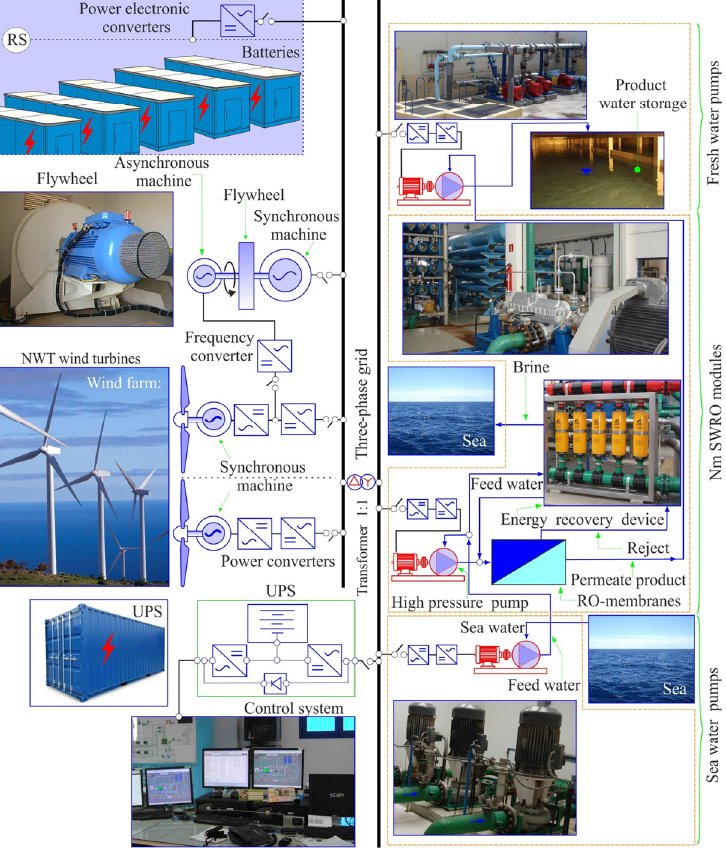
Figure 2. Illustration of the wind-powered seawater RO plant [65]. Image reused under the Creative Commons license.